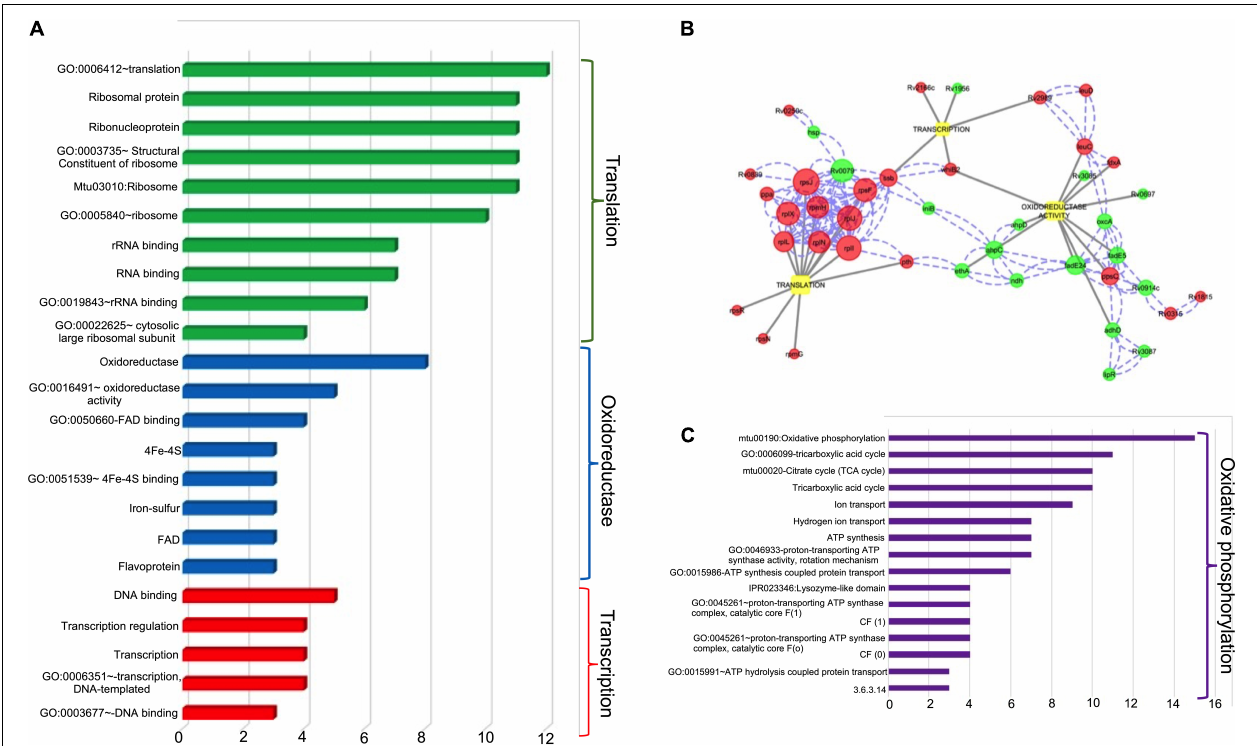
FIGURE 8 | (A) Various Gene Ontology (GO) and Pathways enriched for the three major biological functions altered in the (cid:49) higB1 mutant in comparison to the wild type strain. X axis indicates the number of DEGs under each GO/Pathway. (B) The biological regulatory network for the differentially expressed genes. The red color and green circles represent upregulated and down regulated genes in the (cid:49) higB1 mutant strain in comparison to the parental strain. The blue dotted lines indicate physical protein-protein interaction and gray solid lines indicate regulation of specific biological functions. The size of the nodes indicates the connectivity score (bigger the size – higher the score). (C) Various Gene Ontology (GO) and Pathways enriched for the major biological function altered in the complemented strain in comparison to the wild type strain. X axis indicates the number of DEGs under each